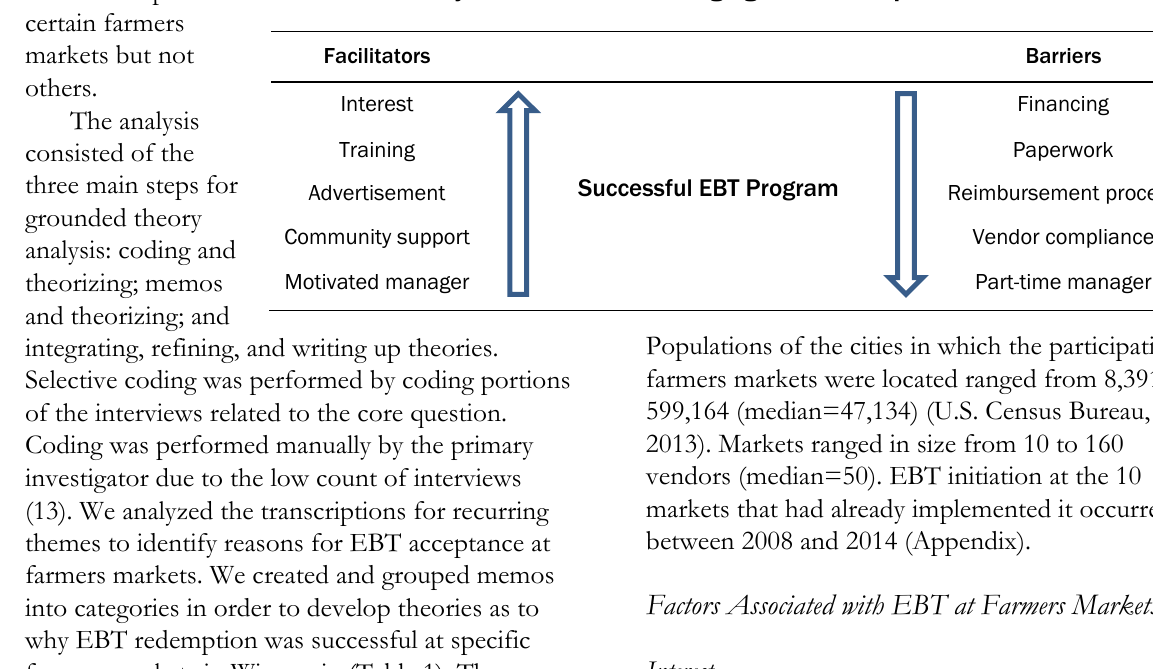
Table 1. Summary of Main Themes Emerging from Participant